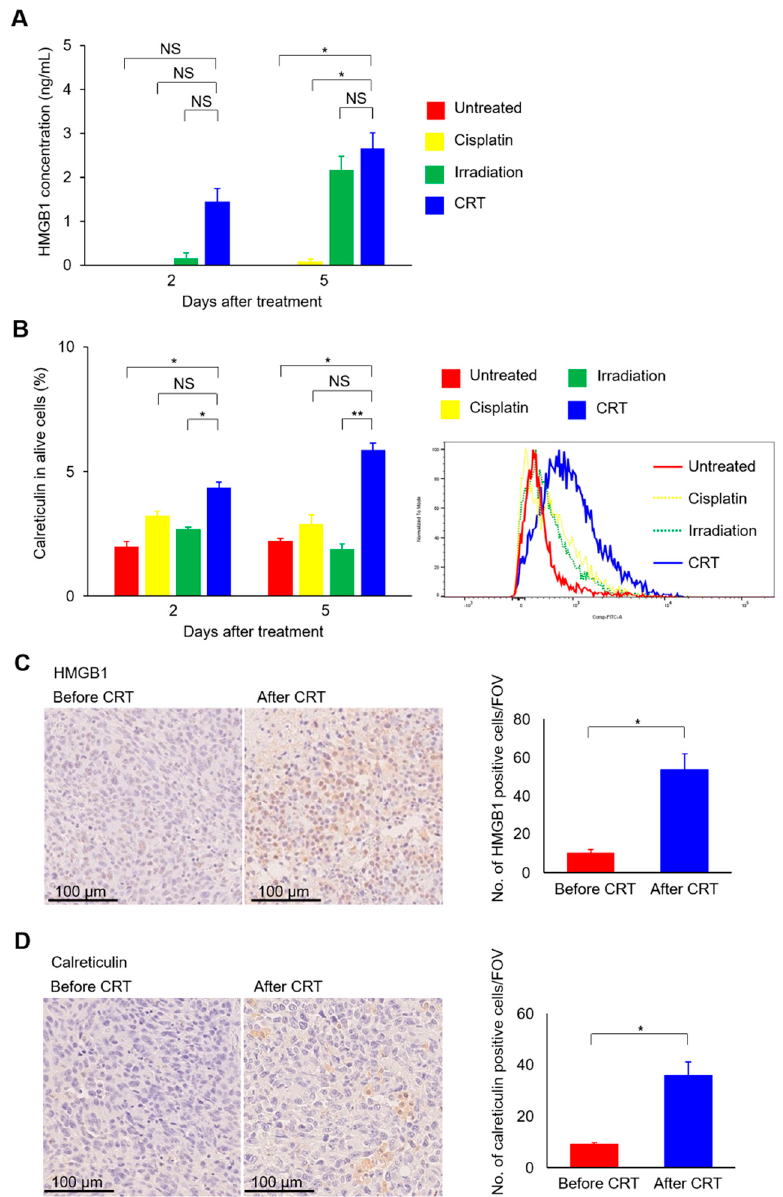
Figure 4. The combination of cisplatin and irradiation increases HMGB1 protein secretion and cell surface expression of calreticulin protein in MB49 cells. ( A ) MB49 cells are treated with cisplatin at 0.6 mg/L and/or irradiated with a single fraction of 10 Gy. Medium is collected two and five days after treatment, and HMGB1 protein expression levels in each medium are examined in duplicate by ELISA ( n = 3/group). ( B ) MB49 cells are treated with cisplatin at 0.6 mg/L and/or irradiated with a single fraction of 10 Gy. Cells are collected, and cell surface calreticulin protein expression levels are examined by flow cytometry ( n = 3/group). ( C , D ) Seven days after inoculation MB49 cells in the left hindlimb, mice are treated with cisplatin at 3 mg/kg and/or irradiation with a single fraction of 10 Gy. Tumor sections before and after CRT ( n = 3/group) are stained for HMGB1 ( C ) and calreticulin ( D ). Left, representative images; right, comparison of the mean (± standard error of the mean [SEM]) number of HMGB1- or calreticulin-positive cells counted in five fields of view (FOV). All data are shown as the mean ± SEM. Asterisks indicate p values comparing two groups, as indicated in the figure. NS, not significant; * p < 0.05; ** p < 0.01.